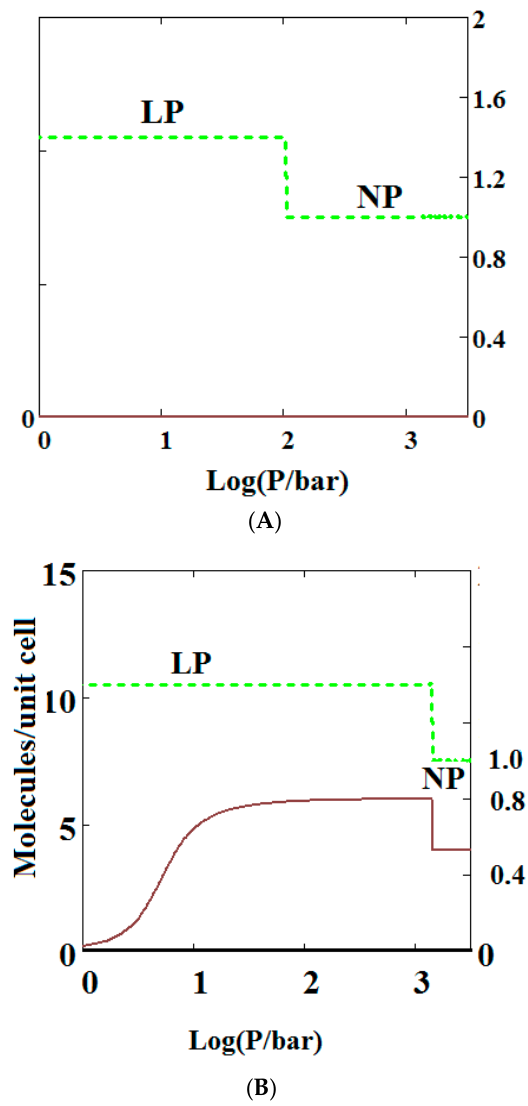
Figure 2. ( A ) Mechanical compression of MIL ‐ 53 at 300 K, using the parameters given in Reference [30]. At higher pressures there is mechanical compression of the metal ‐ organic frameworks (MOF) to the narrow pore (NP) state. The axis on the right measures the volume in units of the NP volume; ( B ) adsorption isotherms of pure methane calculated using a sharp transformation approach at 300 K using the pure methane parameters given in Reference [30] for MIL ‐ 53. At higher pressures there is negative gas adsorption (NGA) caused by the compression of the MOF to the NP state. The axis on the right measures the solid volume in units of the NP